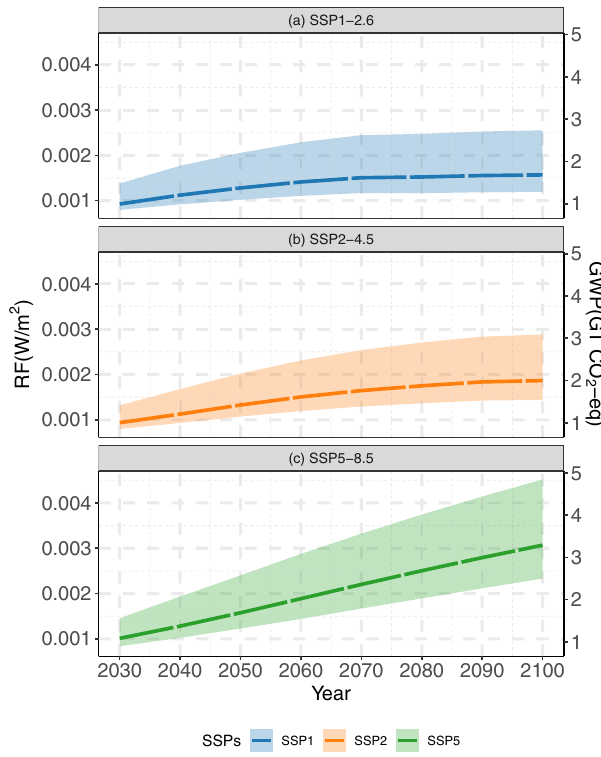
Fig. 3 Top-of-atmosphere radiative forcing (RF, W/m 2 ) due to projected urbanization. The RF due to altered land surface albedo in 2030 – 2100 relative to 2018 for three illustrative scenarios: a SSP1-2.6, b SSP2-4.5, and c SSP5-8.5. The shaded area shows the 90% con fi dence intervals resulting from urbanization likelihood based on 100 urban expansion